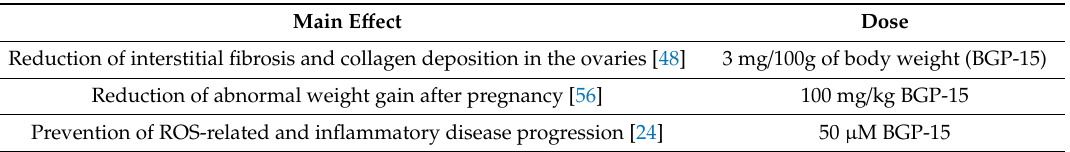
Table 8. Summary of the investigations related to e ff ects of BGP-15 in gynecological diseases. Main E ff ect